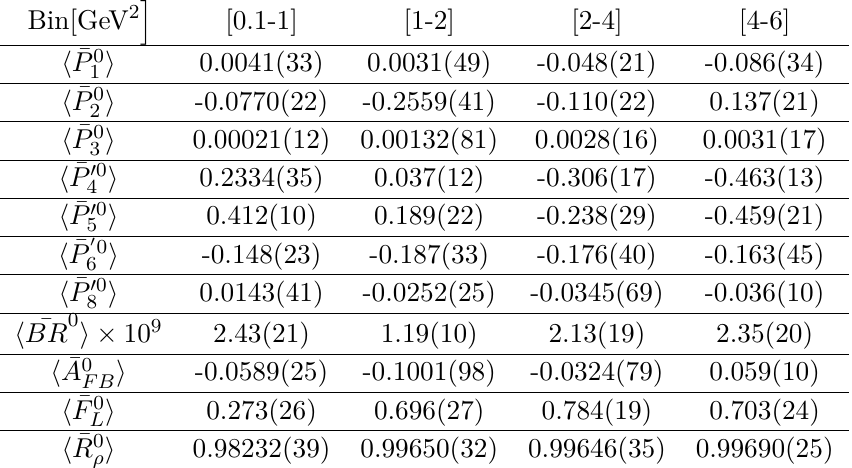
¯ B 0 → ρ 0 ‘‘ decays measurable at